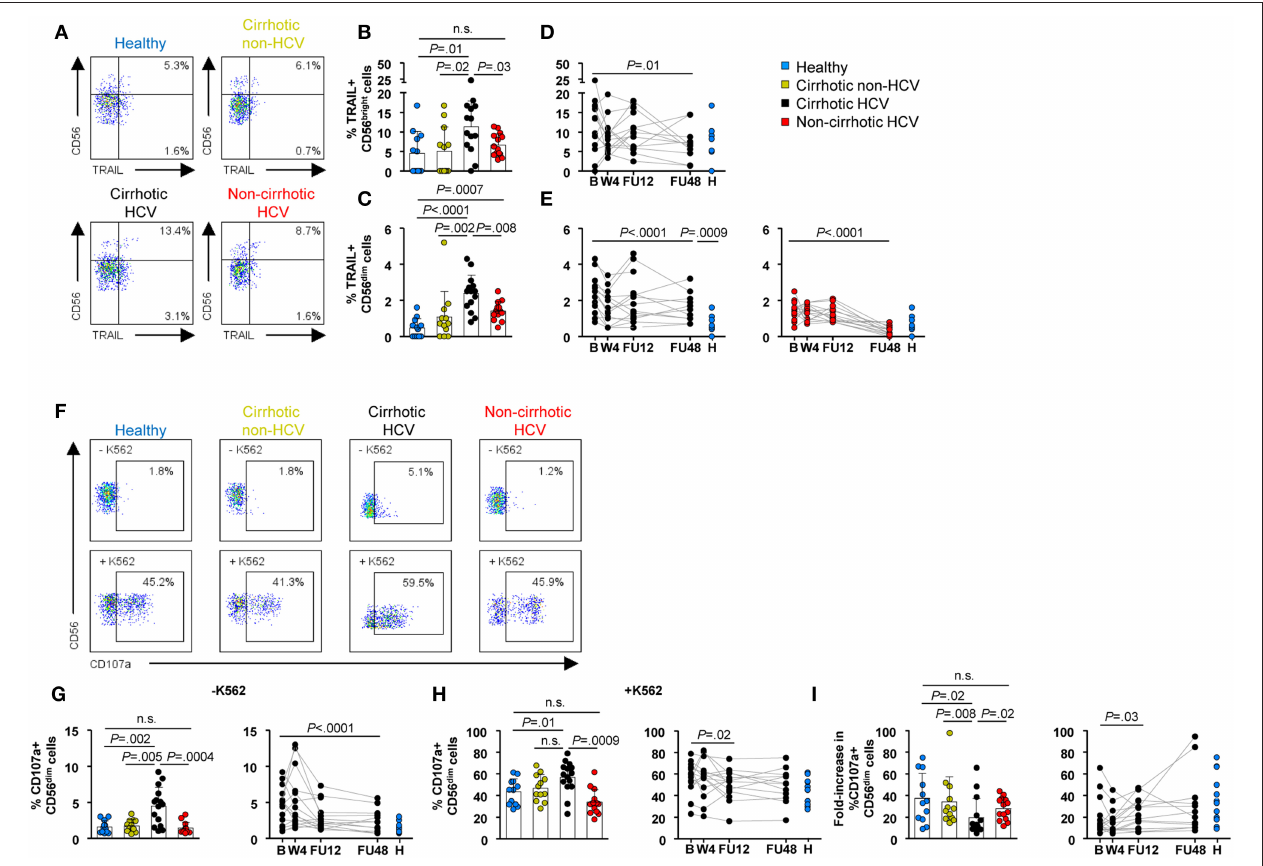
FIGURE 5 | NK cytotoxicity differed between HCV patients with and without cirrhosis at baseline and remained upregulated in cirrhotics after IFN-free therapies. (A) Representative flow cytometry plots, (B,C) baseline frequencies, and (D,E) longitudinal analysis of TRAIL within CD56 bright and CD56 dim cells. (F) Representative flow cytometry plots of CD107a + CD56 dim cell frequencies with or without coincubation with K562. (G) Ex vivo baseline frequency of CD107a + CD56 dim cells and longitudinal analysis. (H) Baseline frequency of CD107a + CD56 dim cells and longitudinal analysis upon stimulation with K562 cells. (I) Degranulation capacity (fold increase) of CD56 dim cells at baseline and during longitudinal analysis. PBMC samples from 14 cirrhotic and 15 non-cirrhotic HCV patients were available in sufficient cell numbers for the evaluation of TRAIL and CD107a expression, respectively.